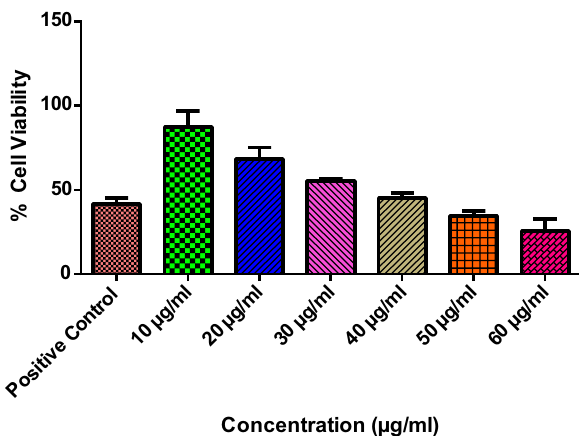
Figure 6: The experiment shows the results of a cell cytotoxicity assay using MTT and ZnO – TiO 2 – chitosan – escin bio - nanocompo - sites at di ff erent concentrations ( 10, 20, 30, 40, 50, and 60 µg · mL − 1 ) in MOLT4 cells in 96 - well plates. Experiments were performed in triplicate to determine the IC 50 value, and representative data are shown here for the dose resulting in 50% inhibition of cell growth.